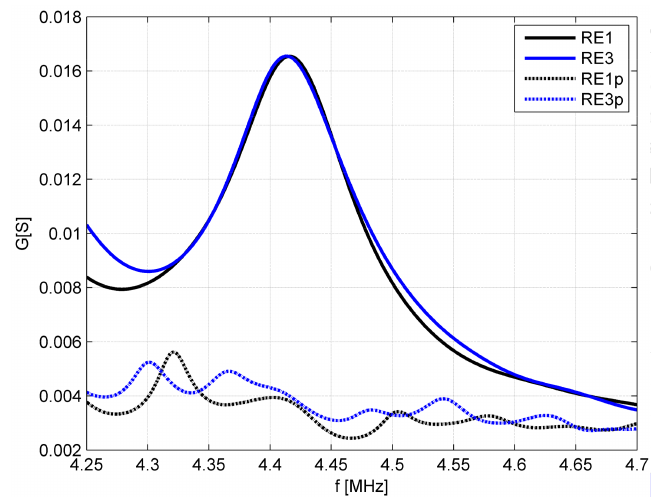
Figure 7. Conductance curves for 4.25–4.70 MHz range for two reference samples (RE1 and RE3) and respective free piezoelectric sensors before bonding (RE1p and RE3p).